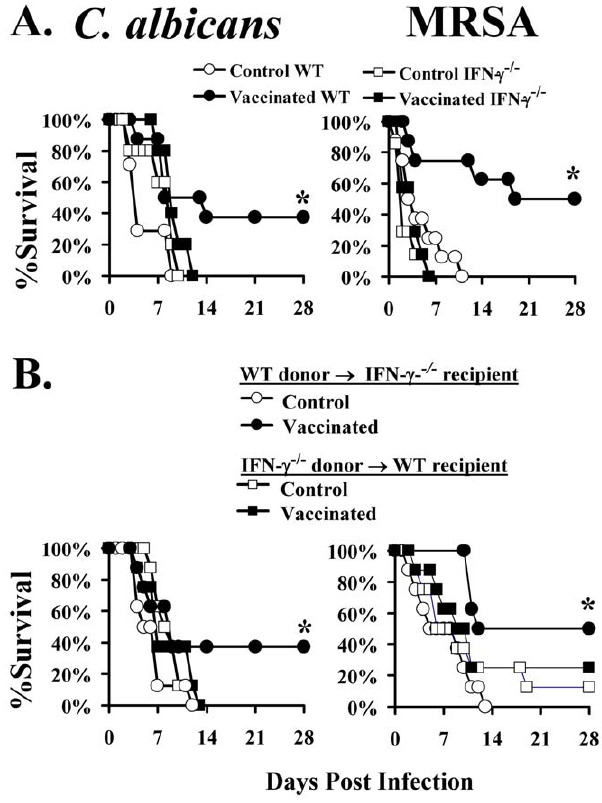
Figure 1. CD4 derived IFN- c is required for vaccine protection. Wild type Balb/c mice were infected with 2 6 10 5 C. albicans SC5314 or 2 6 10 7 S. aureus LAC; IFN- c deficient mice on a Balb/c background were infected with 10 5 C. albicans or 10 7 S. aureus . A) Wild type, n=8 mice per group, or IFN- c deficient mice, n=7 mice per group, were vaccinated and infected iv via the tail-vein 2 weeks after the booster dose. *p , 0.05 for wild type vaccinated vs. control by Log Rank test. B) CD4 + T cells, 5 6 10 6 , from vaccinated or control mice were adoptively transferred iv to recipient mice, n=8 mice per group, 24 h prior to infection. *p , 0.05 for wild type donor cells vaccinated vs. control